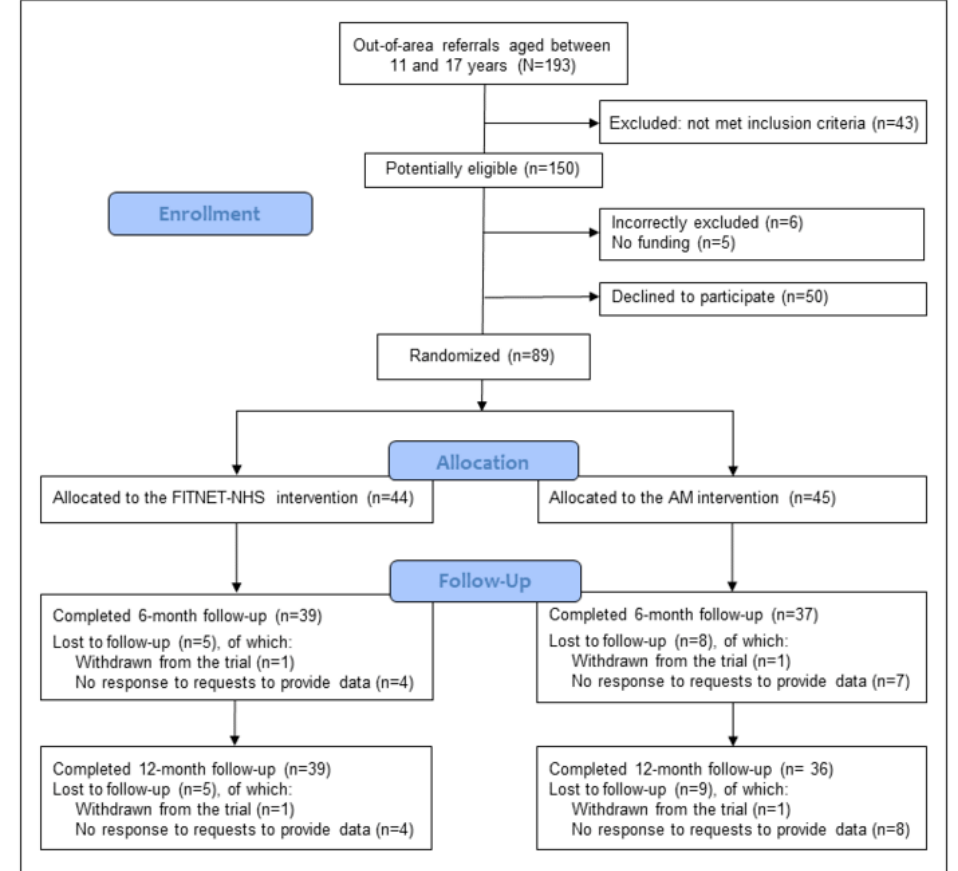
Figure 1. Consolidated Standards of Reporting Trials flow diagram. AM: activity management; FITNET-NHS: Fatigue in Teenagers on the InterNET in the National Health